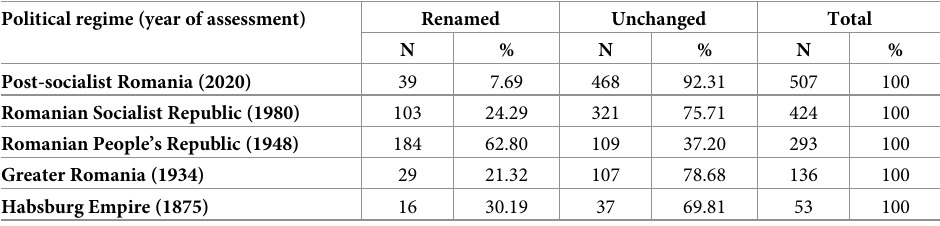
Table 3. Overview of Sibiu’s street name changes by political